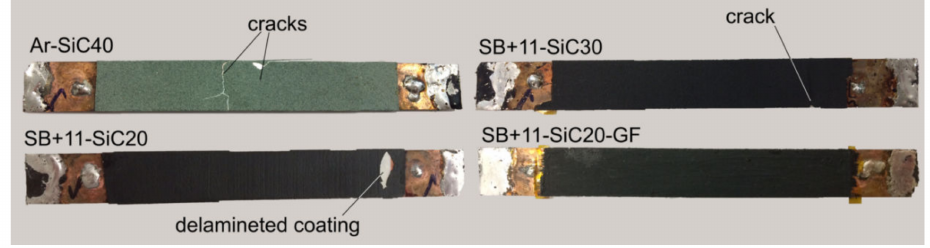
Figure 10. Samples after limitation experiment with 9 cells and 50 ms DC